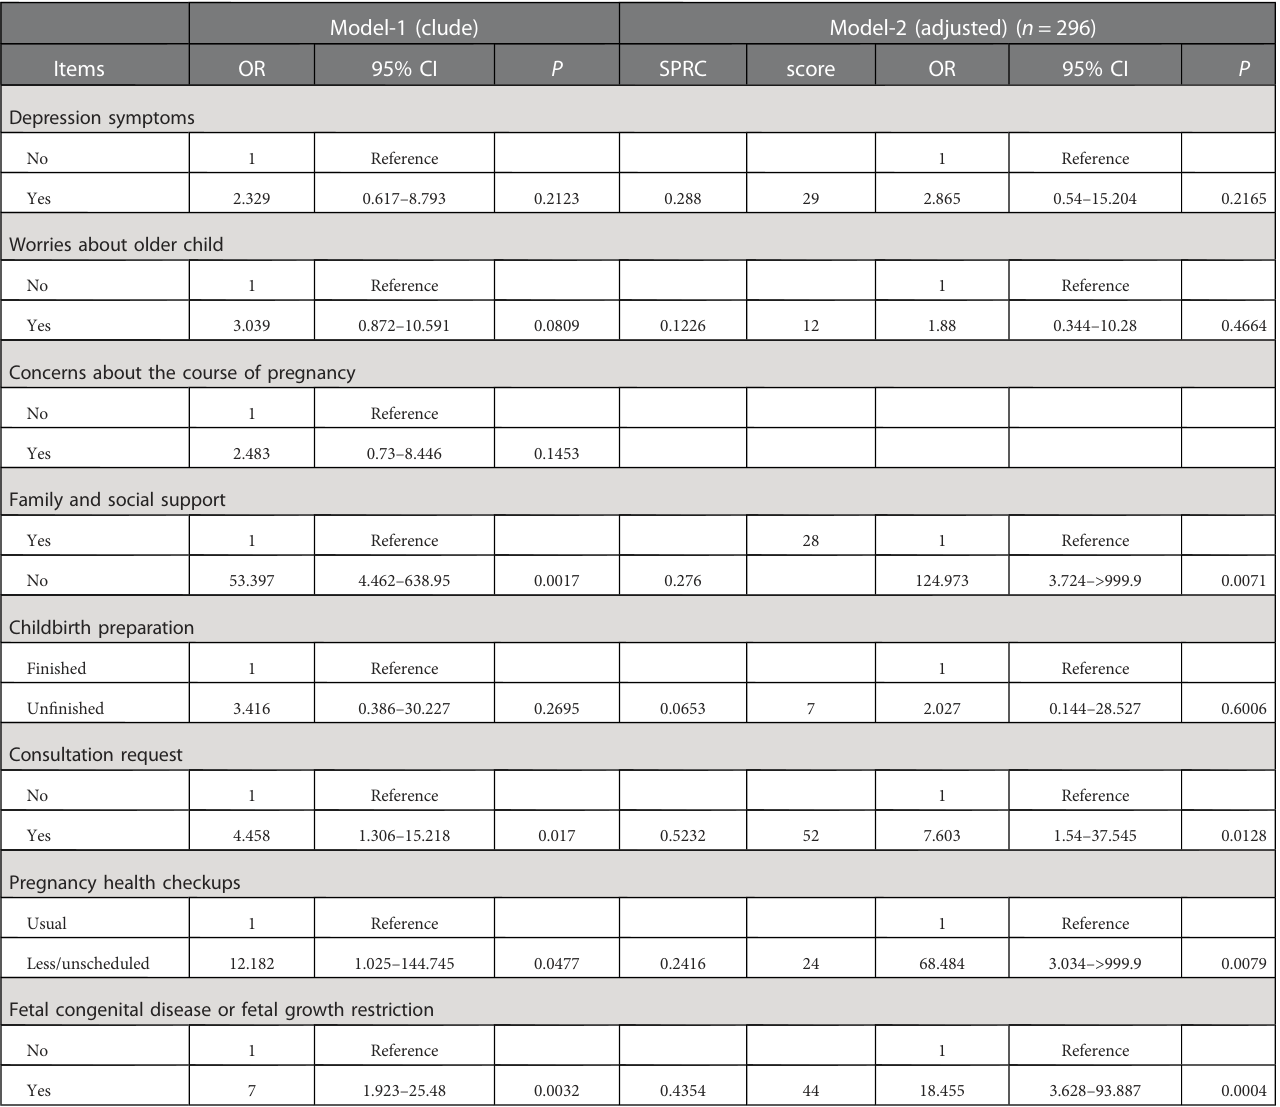
TABLE 5 The multiple linear regression analysis during the third